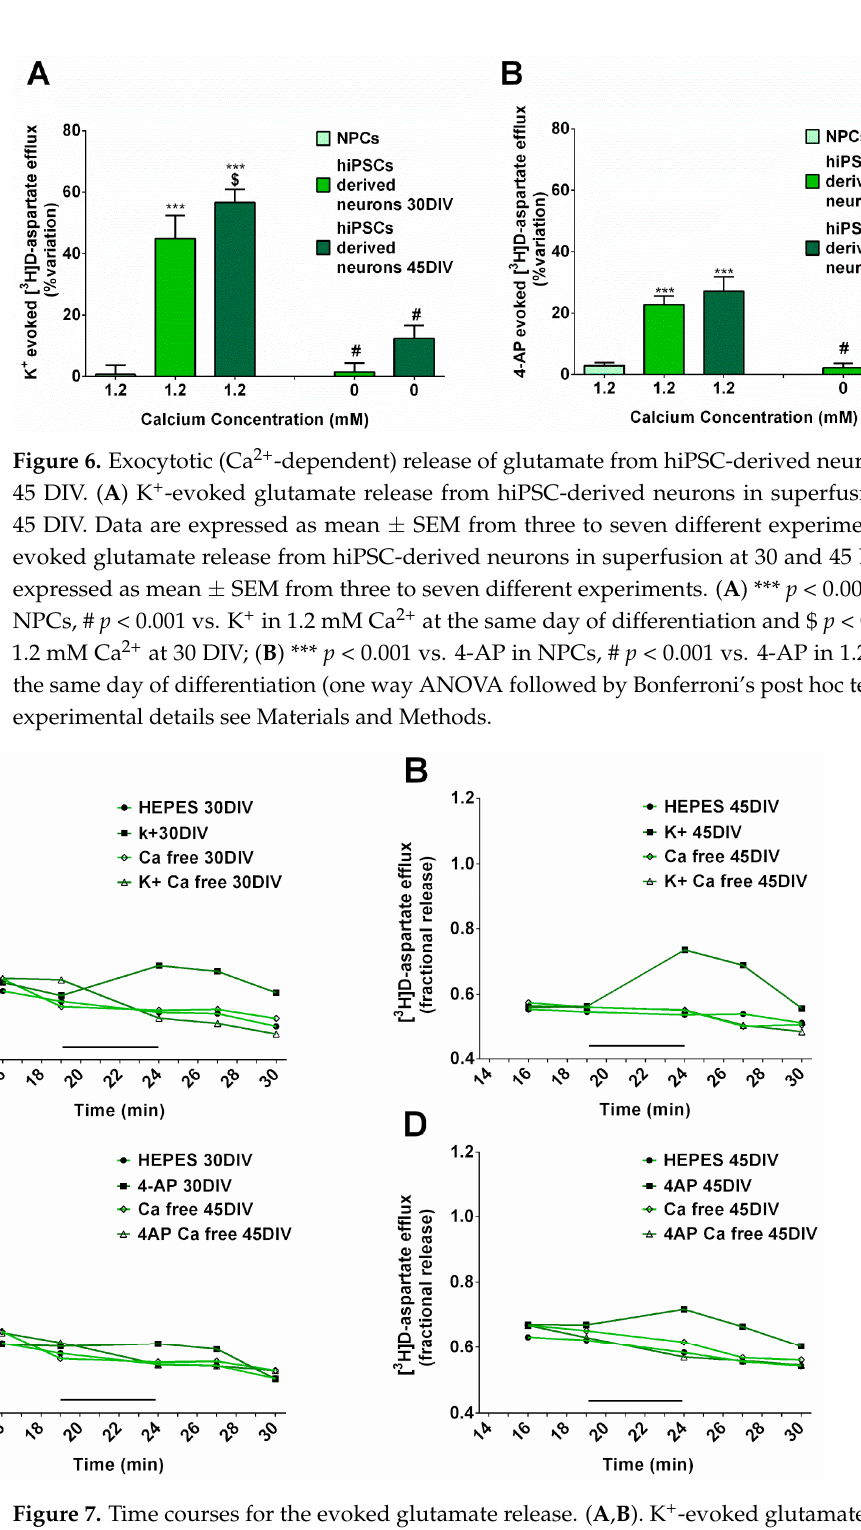
Figure 7. Time courses for the evoked glutamate release. ( A , B ). K + -evoked glutamate release from hiPSC-derived neurons in superfusion. Representative time-courses for the release of tritium from hiPSC derived neurons at 30 ( A ) and 45 ( B ) day of differentiation are shown. K + was added (3 min; black bar) during superfusion. ( C , D ). 4-AP-evoked glutamate release from hiPSC-derived neurons in superfusion. The representative time courses for the release of tritium from hiPSC-derived neurons at 30 ( C ) and 45 ( D ) days of differentiation are shown. 4-AP was added (3 min; black bar) during superfusion. For other experimental details see Materials and